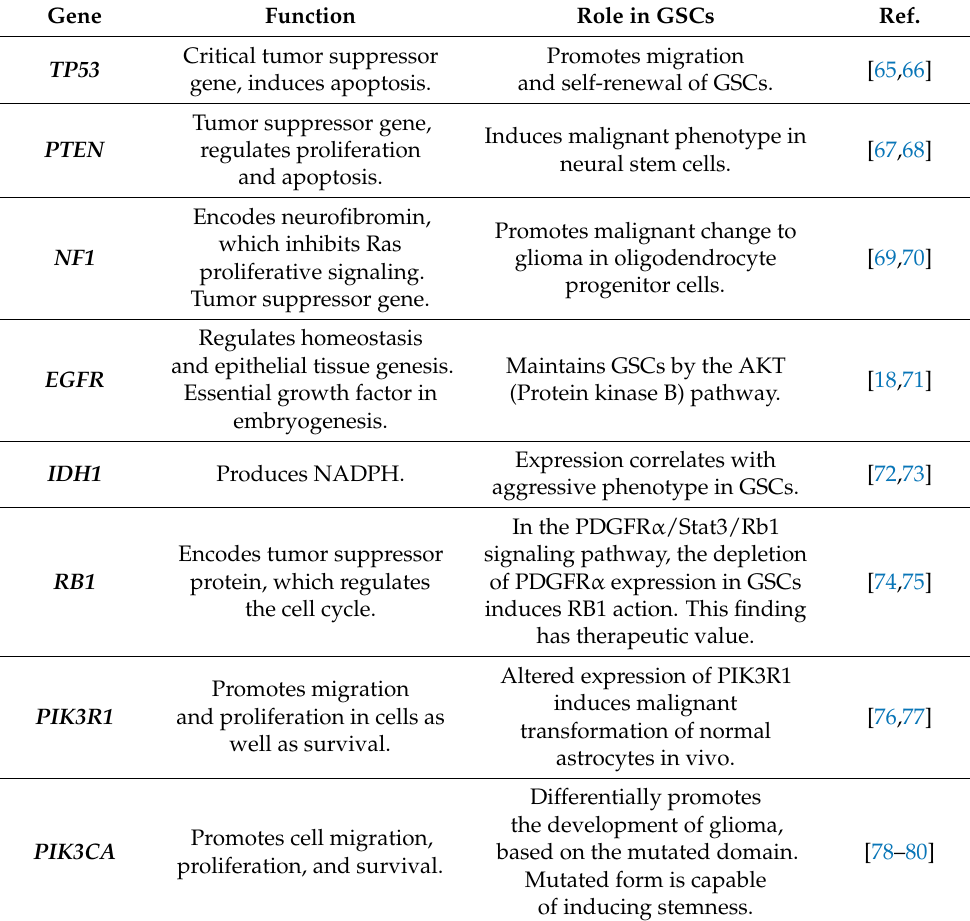
Table 1. Most commonly mutated genes in glioblastoma: general functions and roles in glioma stem